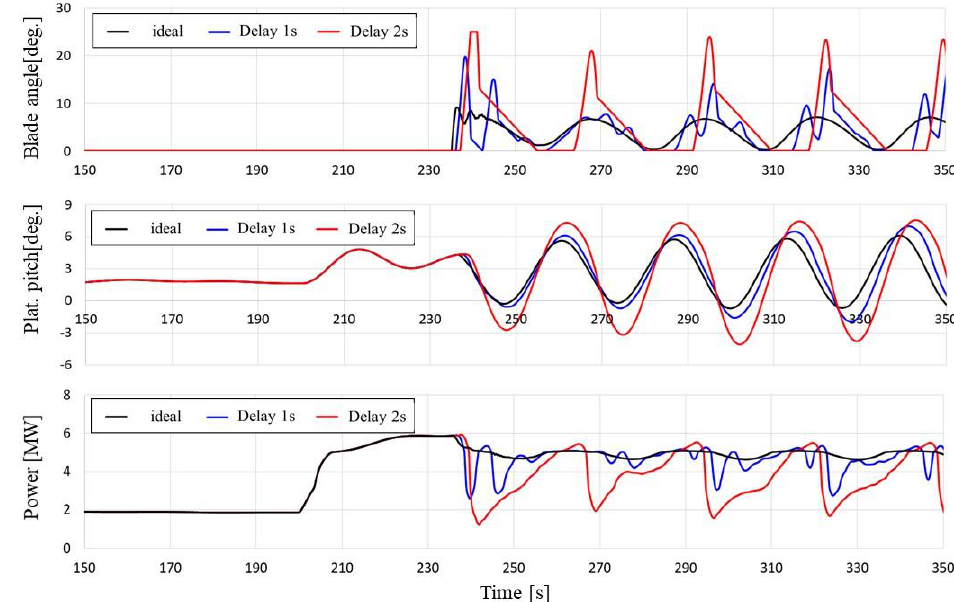
Figure 5. Results of step changes in wind speed according to the delay in the pitch controller response: blade pitch angle, platform (plat.) pitch, output power.